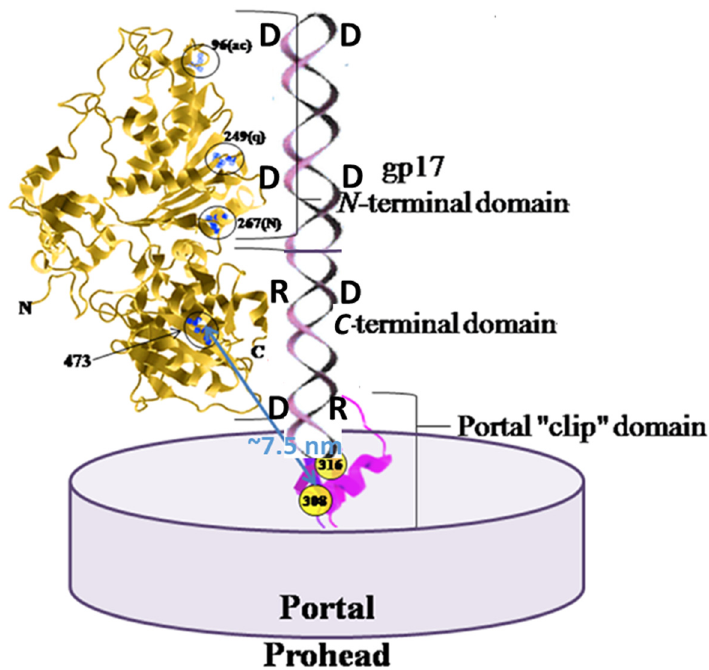
Figure 5. Phage T4 prohead portal gp20 binding to TerL from the C-terminal TerL nuclease containing domain. Two duplex nucleic acid segments are depicted as being translocated by the TerL ATP-driven motor; where the top segment is pushing the bottom segment through the portal tunnel into the prohead. TerL intercalating ac and q dye resistance mutations at residues 96, 249 are circled; mutations at residue 267 are closely coordinated with mutations at the ac and q sites; the circled residue 473 ts DNA translocation mutation is suppressed by portal cs mutation clip domain residue 308 (blue arrow). A FRET determined distance of ca.7.5 nm between portal clip domain Alexa488 maleimide dye labeled residue 316 and the terminase C-terminal ReAsH dye is found in this study (blue arrow). Structures are not to scale, nor are the numbers of terminase or portal monomers represented in the multimeric structure constituting the two-component packaging motor complex.